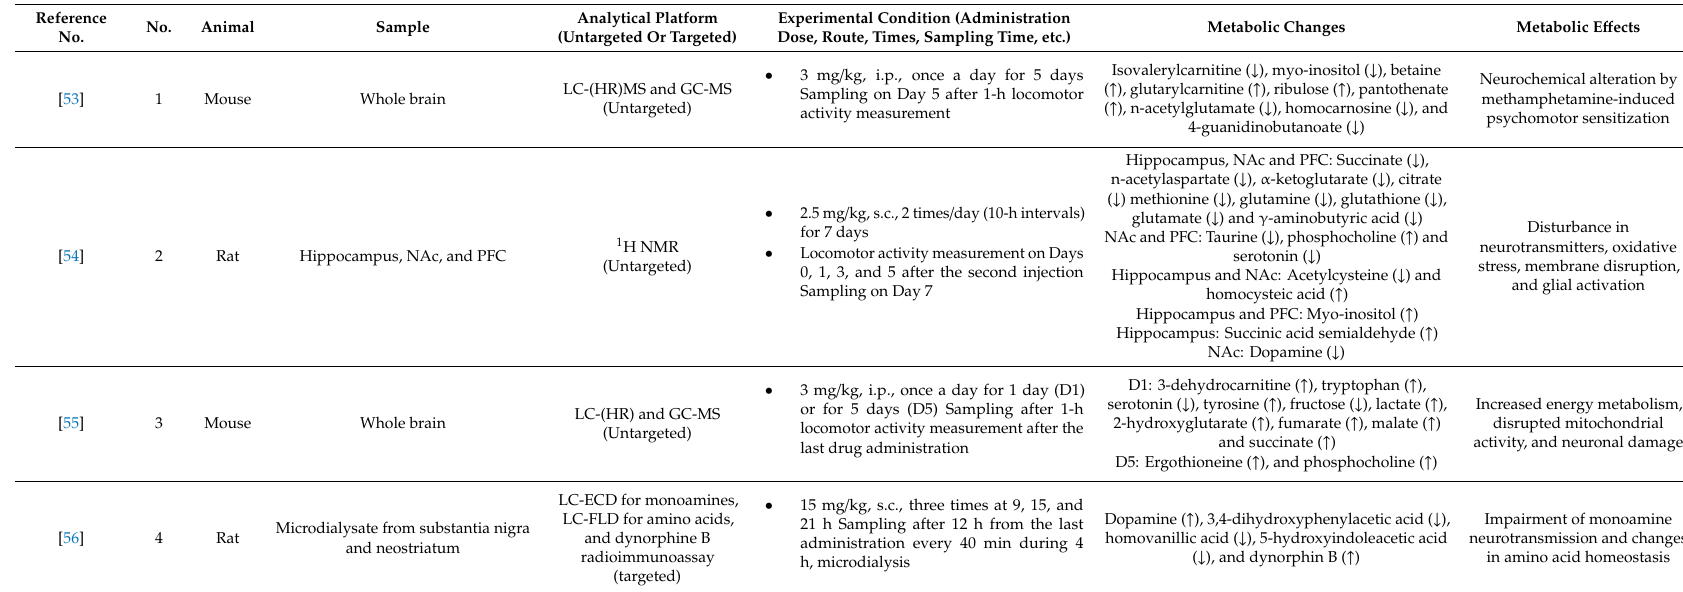
Table 1. Summary of metabolic changes following methamphetamine exposure in animal brain Reference